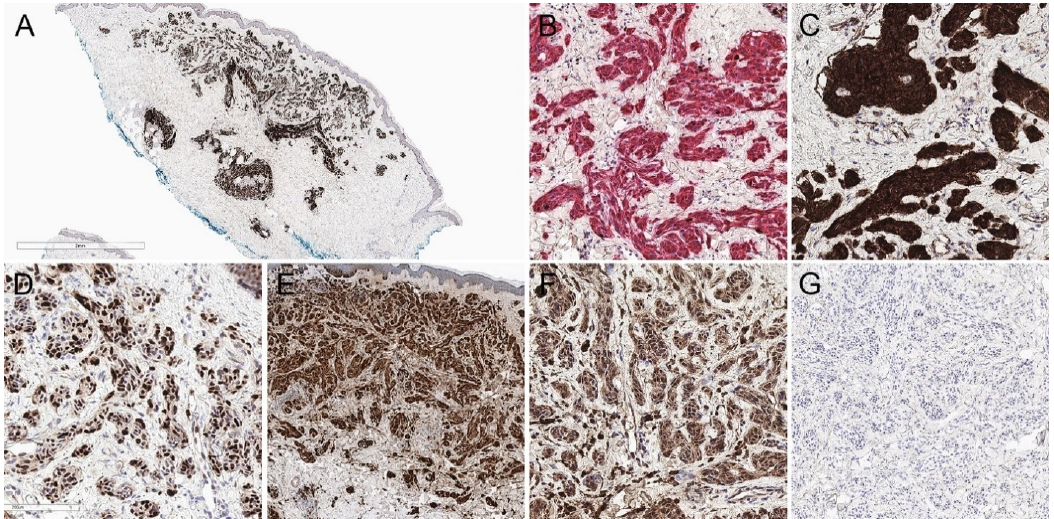
Figure 4. Immunohistochemical features of a deep penetrating nevus. ( A ) Diffuse expression of HMB45 is present (HMB45, 20×). ( B ) Dual MART1/Ki67 staining reveals a low proliferative index (MART1/Ki67, 200×). ( C ) Cytoplasmic, membranous, and nuclear expression of beta-catenin is pre- sent (beta catenin, 200×). ( D ) There is nuclear positivity for cyclin D1 (cyclin D1, 200×). ( E ) P16 is retained (p16, 40×). ( F ) BAP1 nuclear expression is retained (BAP1, 200×). ( G ) Lesional cells are neg- ative for preferentially expressed antigen in melanoma (PRAME) (PRAME, 100×).